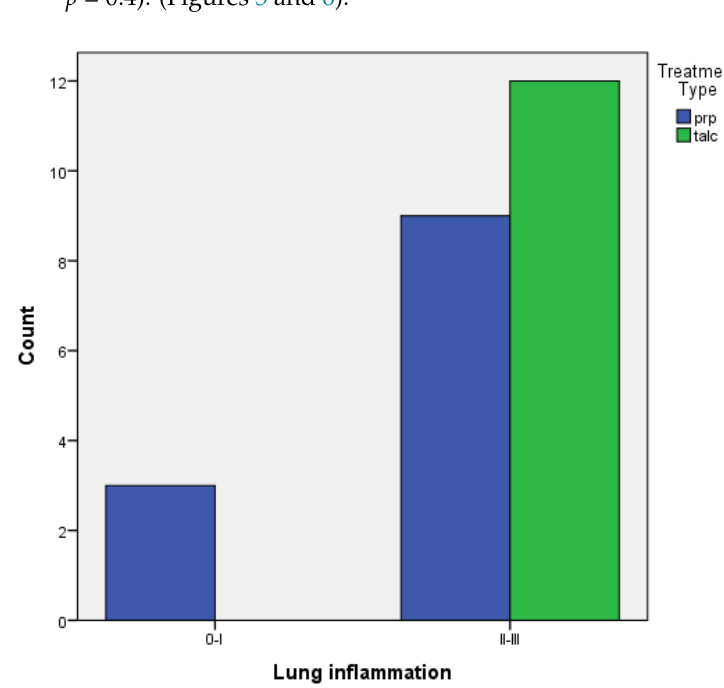
Figure 5. Visceral pleura inflammation of PRP vs. talc.